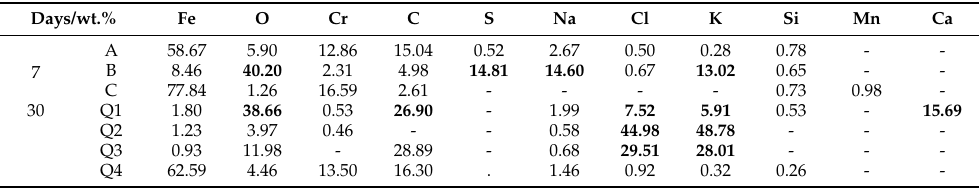
Figure 3. SEM images of stainless steel SS430 surface exposed to SS1 cement extract solution: ( a , b ) two different zones after 7 days and ( c , d ) two different zones after 30 days. Table 8. EDS surface analysis (wt.%) of SS430 exposed to SS1 cement extract solution for 7 and 30 days.